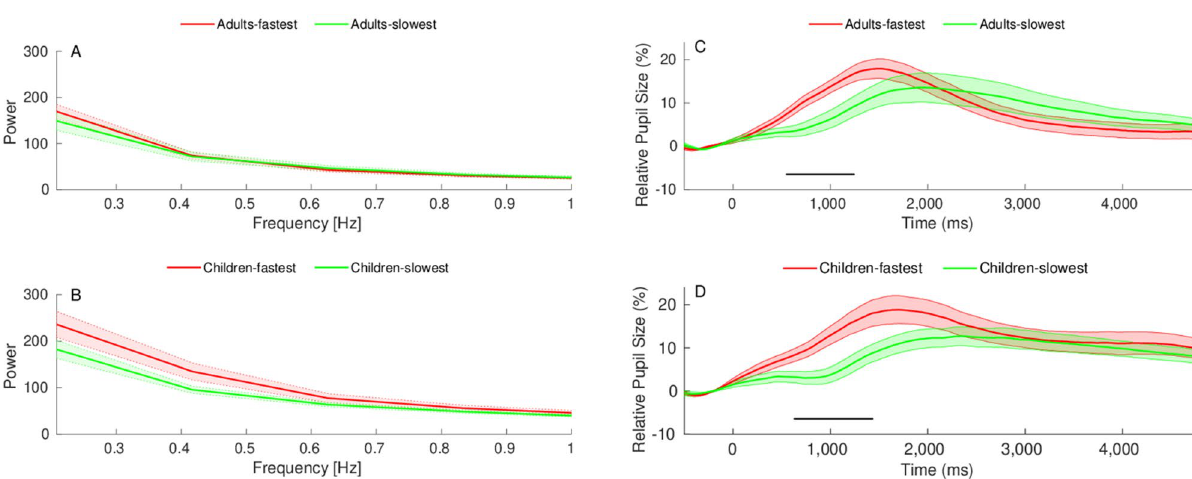
Figure 2. Individual differences in pupil responses to word reading (real words and pseudowords) between faster readers and slower readers. ( A , B ) Power as a function of frequency (smaller than 1 Hz) among the ( A ) adult sample. ( B ) school-aged sample. ( C , (D ) Relative changes in pupil size from stimulus onset (Time 0) to 4800 ms among the ( C ) adult sample. ( D ) school-aged sample. The shaded areas depict standard errors of the